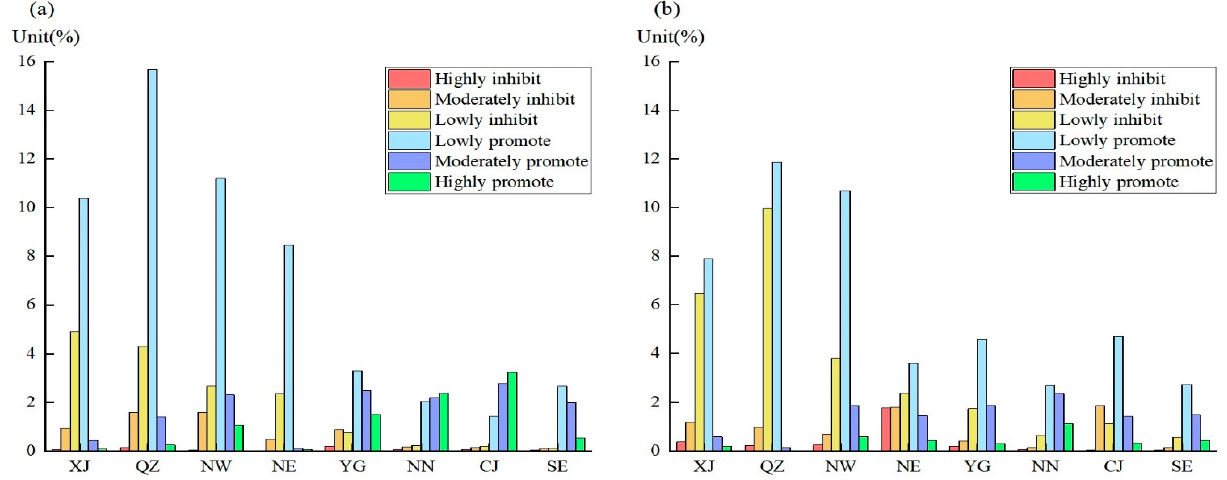
Figure 14. Classified statistics of impacts of climate change ( a ) and human activities ( b ) in eight